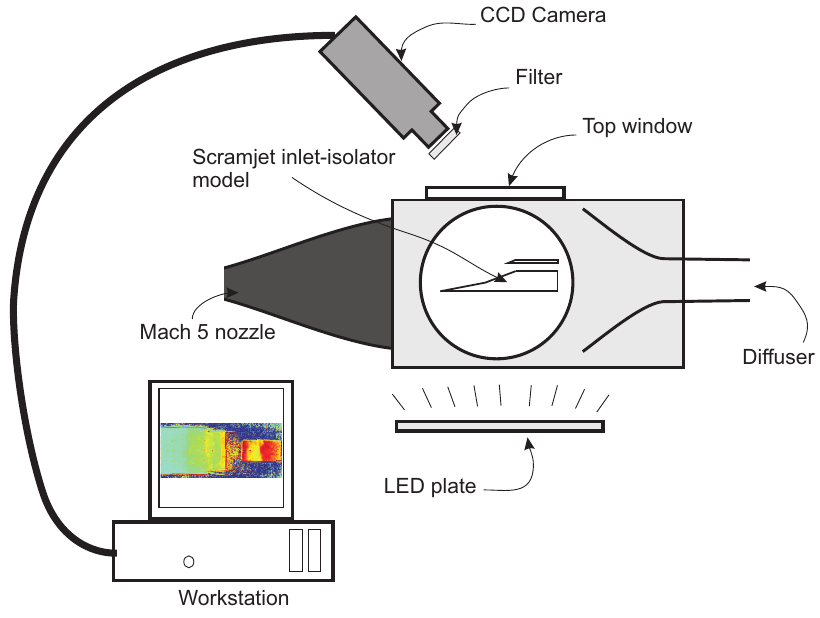
Figure 6. Side view of the pressure-sensitive paint (PSP) Setup 1 system configurations, where the pressure map on the isolator surface was recorded by placing the camera on